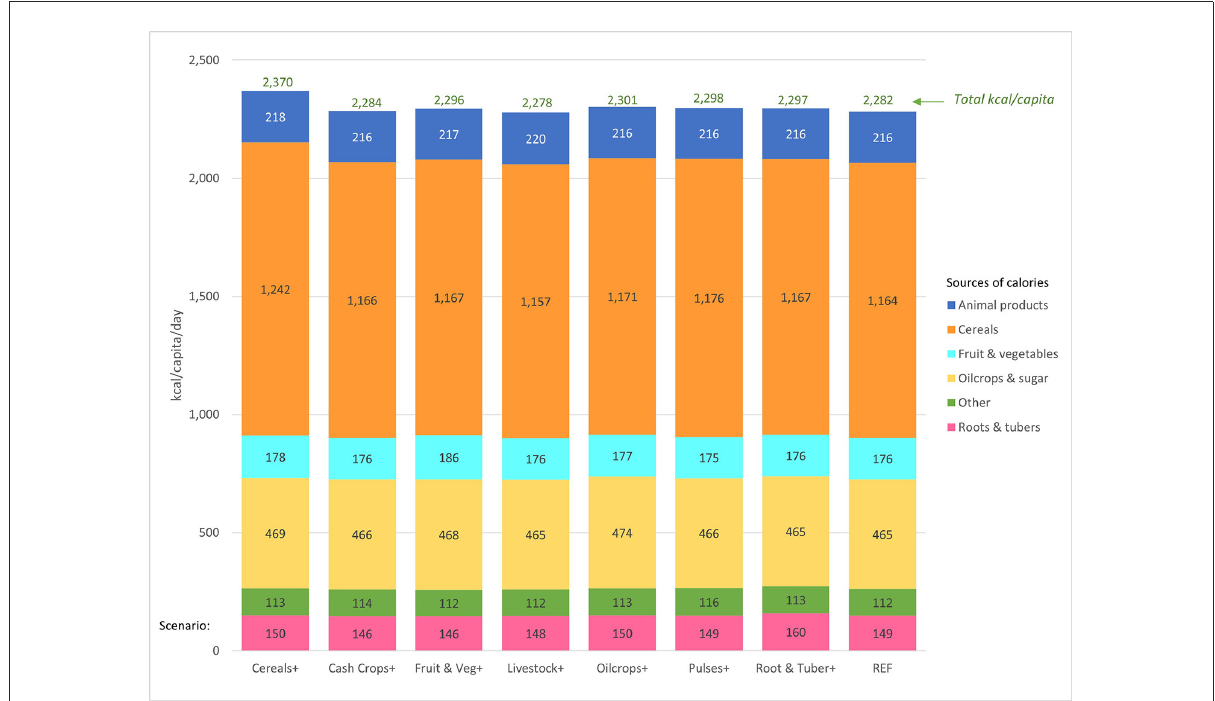
FIGURE4 Sources of calories in the average consumer diet under commodity productivity scenarios. Scenario: commodity demand is based on population and income projections for 2030. The reference scenario (REF) holds commodity yields at 2010 levels. The other scenarios increase the yield of each commodity group by 25% over the 2010 yield level while holding yields of other commodities unchanged. Consumers adjust food consumption in response to relative price changes among